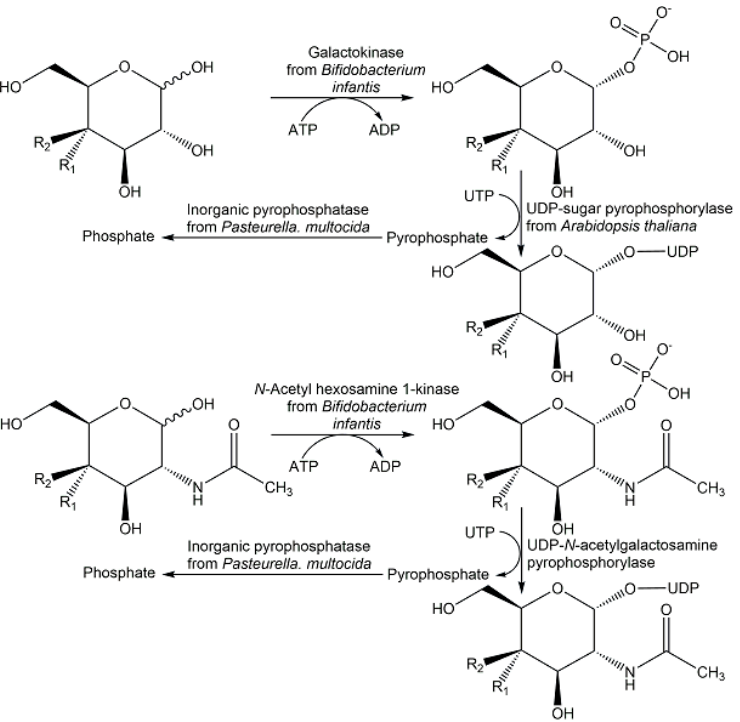
Figure 19. Enzymatic synthesis of uridine 5 ′ -diphosphate sugars as examples of nucleotide sugar synthesis by using enzymes of the salvage pathway.